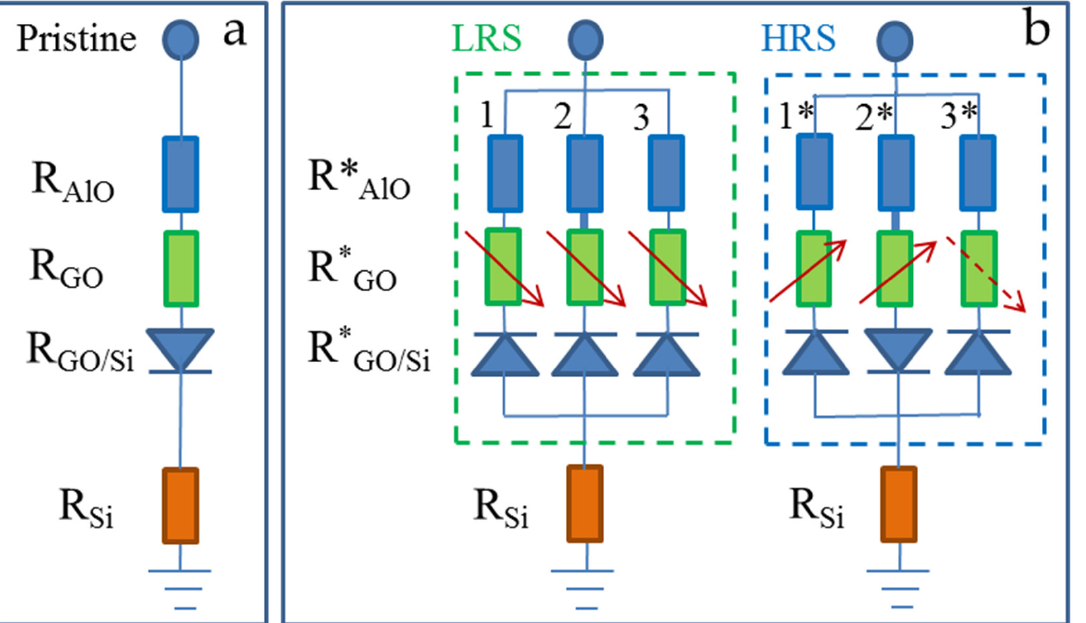
Figure 7. Equivalent circuits of the Al/GO/n-Si MIS structure: ( a ) pristine device; ( b ) illustration of conductive channels formed under DC voltage sweep resulting in HRS-to-LRS (green dash-lined rectangle) and LRS-to-HRS transition (blue dash-lined rectangle). Directions of arrows indicate changes in resistance of conductive channels. Symbols of diode illustrate the presence of rectifying contacts at the GO/Si interface due to either positive charge in pristine GO film or formation of conductive channels near/at the GO/Si interface. The meaning of asterisks is explained in the text. The presence of the GO bulk traps for the holes was established by measuring the